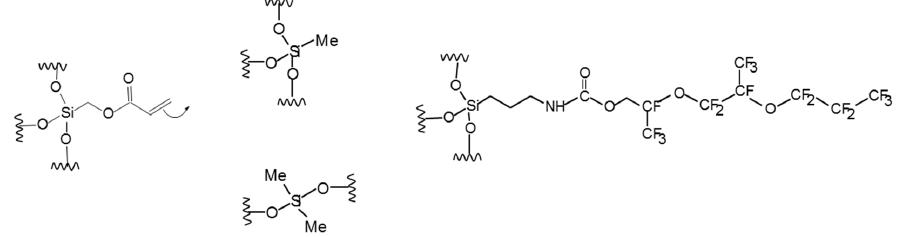
Figure 3. Single component system with perfluorodecyl (PFD), represents the inorganic network.